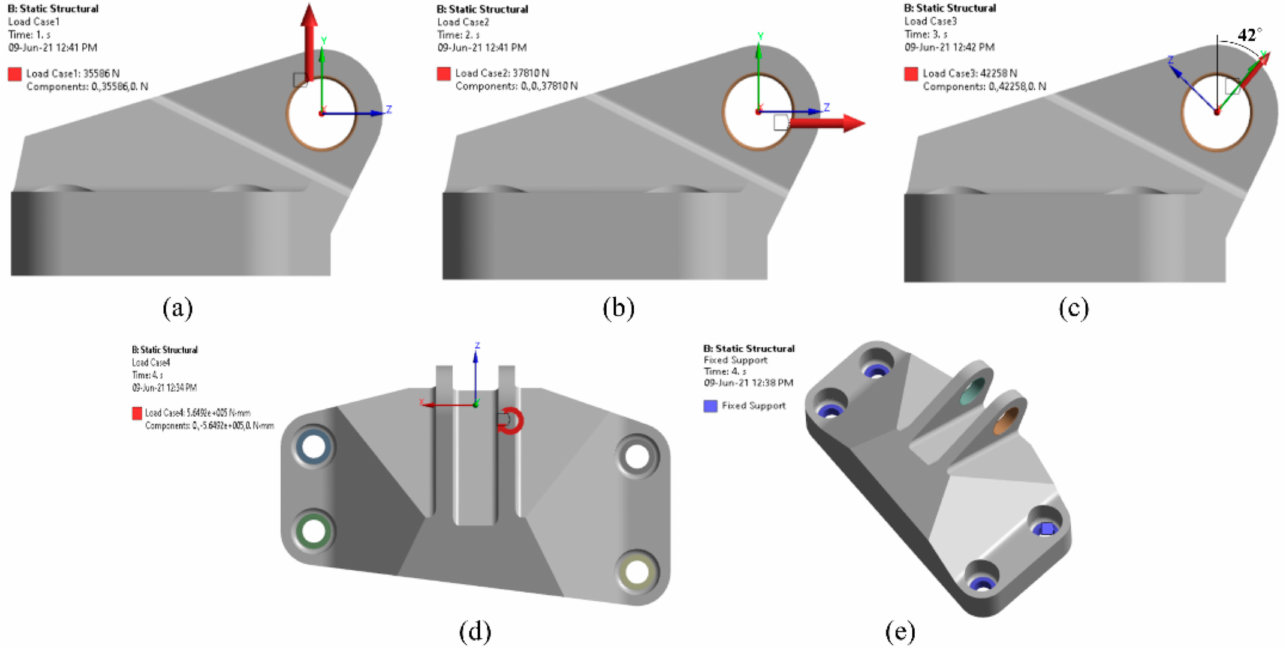
Figure 3. The 3D model of the GE bracket, the used load cases, and the boundary conditions: ( a ) LC1, ( b ) LC2, ( c ) LC3, ( d ) LC4, and ( e ) the boundary conditions.